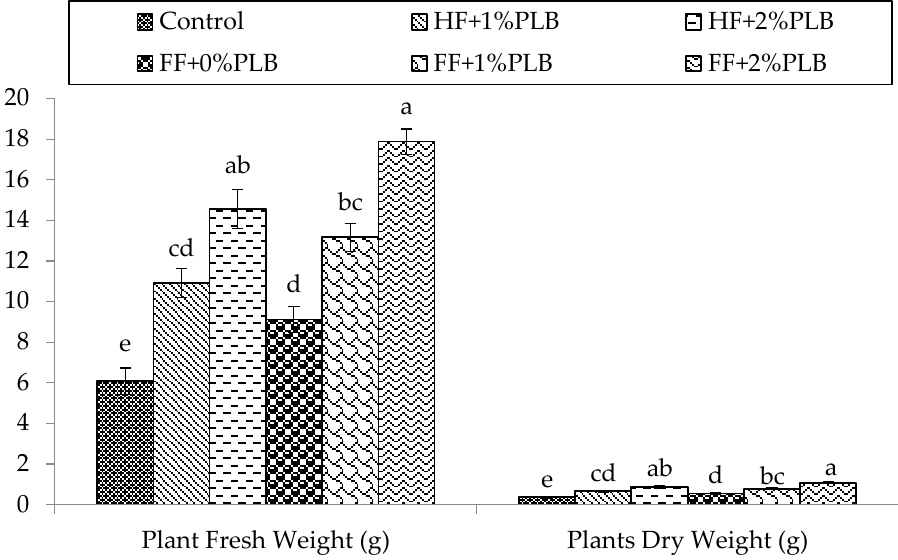
Figure 2. Effect of Pongamia pinnata L. leaves biochar (PLB 0, 1 and 2%) under HF and FF on Pisum sativum L. plants fresh and dry weight. Bars should be compared within a group (plant fresh weight or plant dry weight). Bar heights are different when there are no letters (a, b, c, d, e) are common ( p < 0.05).